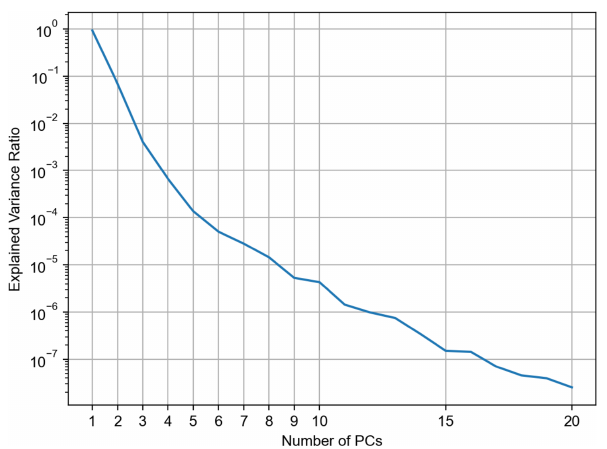
Figure 3. Explained variance ratio as a function of the number of principal components of the spectral